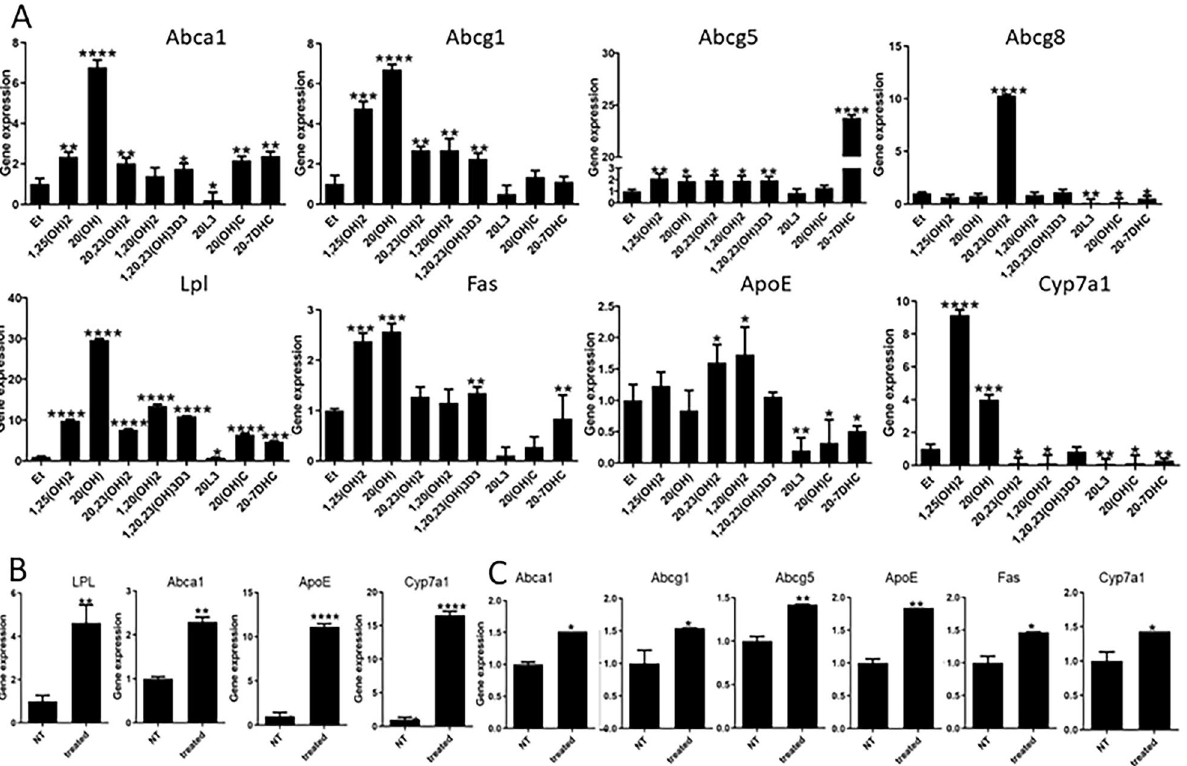
Figure 3. Vitamin D and lumisterol hydroxyderivatives stimulate the expression of LXR-dependent genes. ( A ) QPCR analysis of changes in expression of genes downstream of LXR in murine dermal fibroblasts treated with 10 –7 M 1,25(OH) 2 D3, 20(OH)D3, 1,20(OH) 2 D3, 20,23(OH) 2 D3, 1,20,23(OH) 3 D3, 20(OH)7DHC, 20(OH)L3 or 20(OH)C, or ethanol (control) for 24 h. ( B ) Stimulation of LXR-dependent gene expression in the brain of SKH-1 ( B ) or Ptch +/− /SKH-1 ( C ) mice (n = 3 per group) treated with 20 µg/kg of 20(OH)D3, respectively,